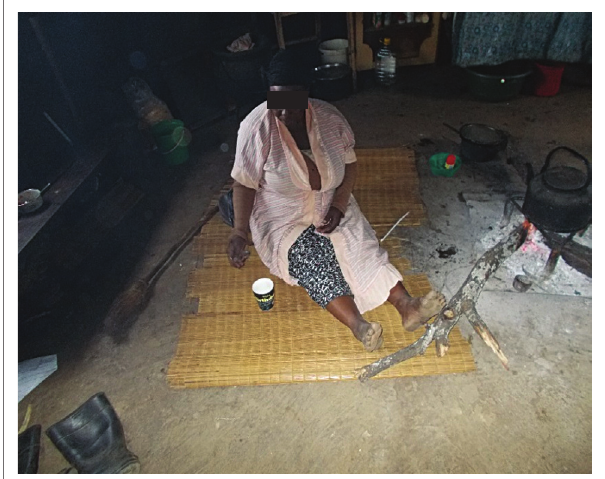
FIGURE 4: This lady who had stroke battles to cook while on the floor in a rondawel.